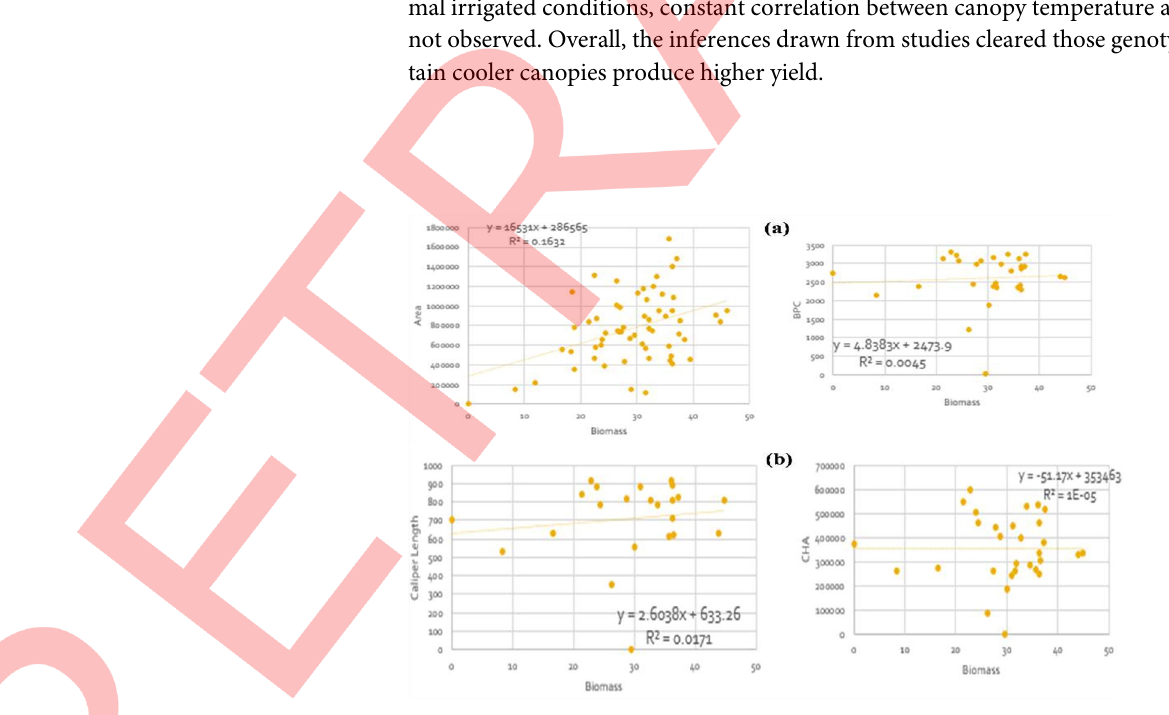
Fig 7. Relationship between surrogates and biomass in control (a) and stressed plants